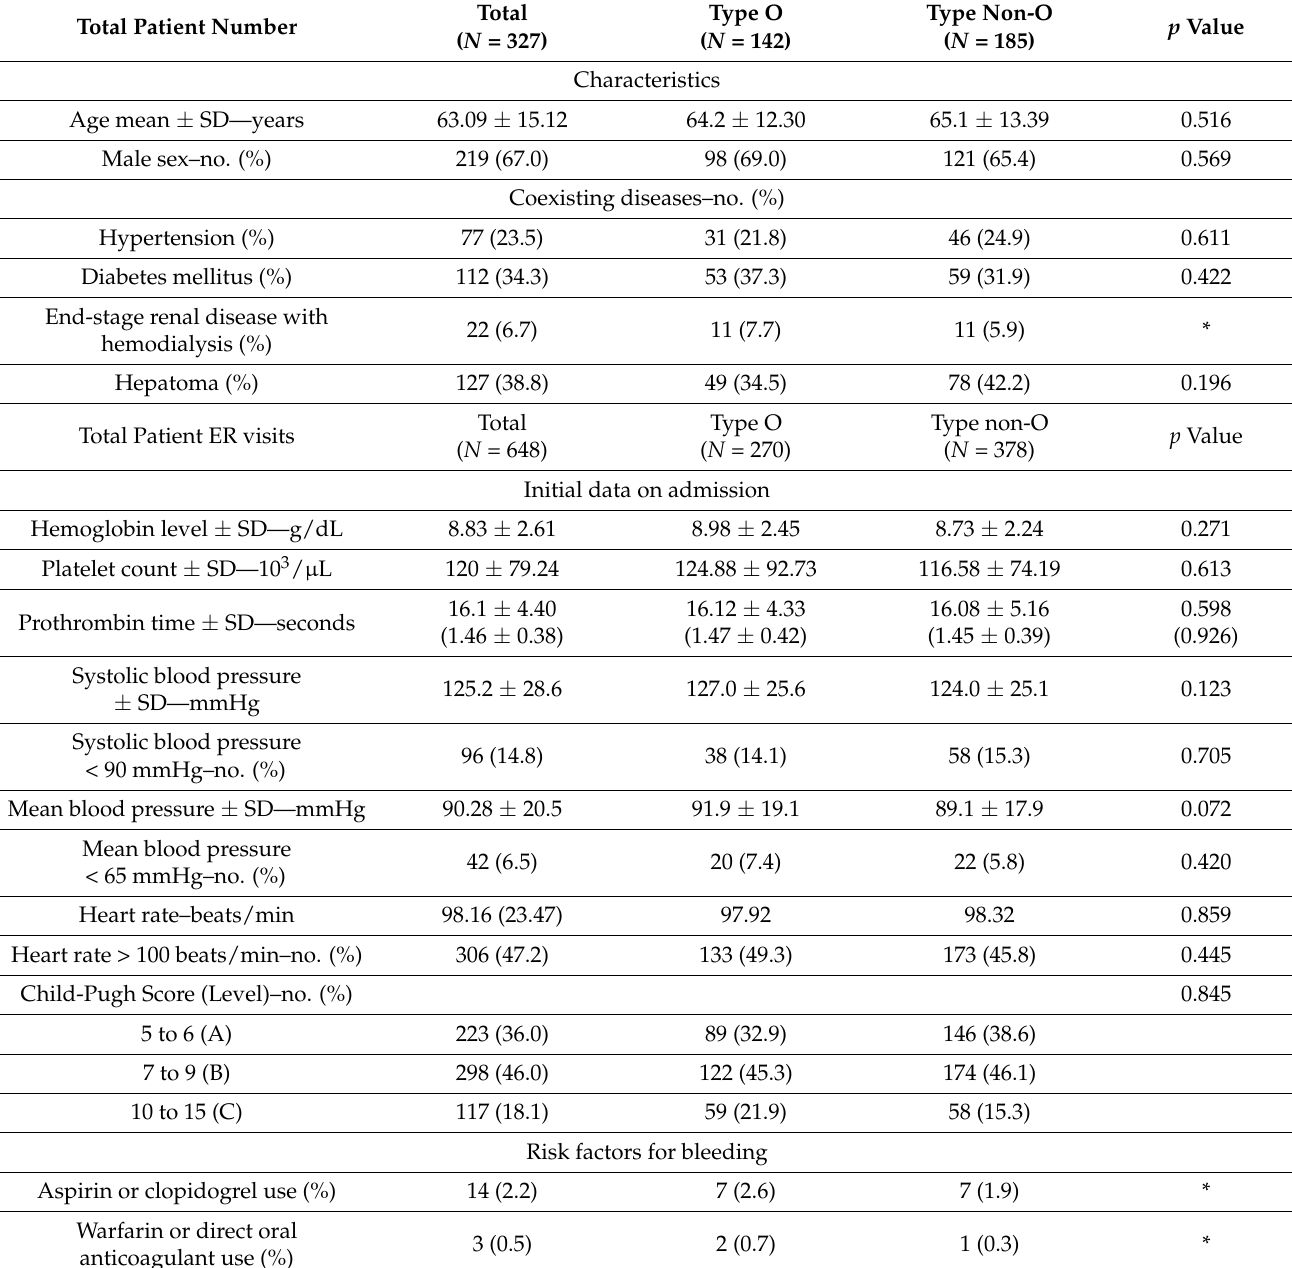
Table 2. Baseline characteristics of the patients’